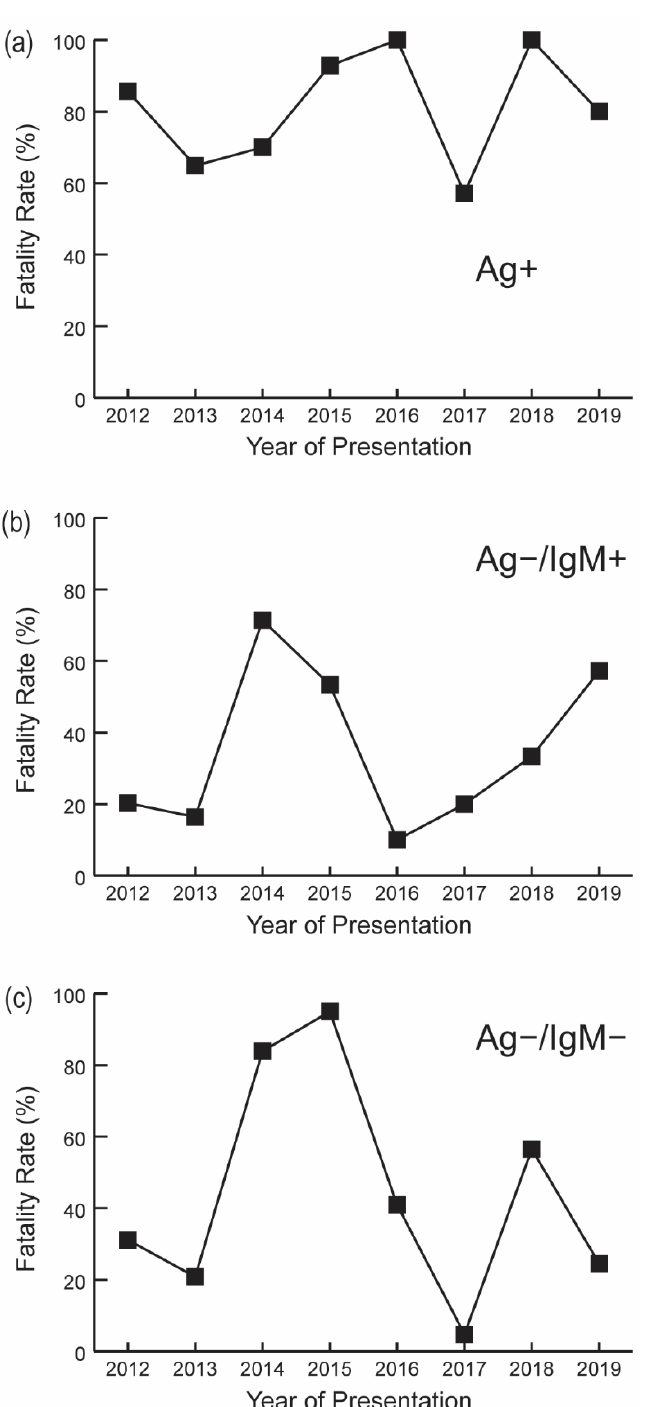
Figure 2. Annual fatality rates by Lassa fever serostatus. ( a ) Acute LF exposure; ( b ) Recent LF exposure (Ag − /IgM+); ( c ) Non-LF or prior LF exposure (Ag − /IgM − ). CFRs among Ag+ cases ranged from 57.1% (8/14) in 2017 to 100.0% (8/8) in 2018. Fatality rates for Ag − /IgM+ subjects ranged from 10.0% (1/10) in 2016 to 71.4% (25/35) in 2014. Ag − /IgM − fatality rates peaked in 2015 and were lowest in 2017 (95.0% [38/40] versus 4.8% [2/42], respectively). Average CFRs prior to the 2014–2016 Ebola epidemic (2012–2013) were 73.8% (48/65) compared with 88.9% (16/18) following the epidemic